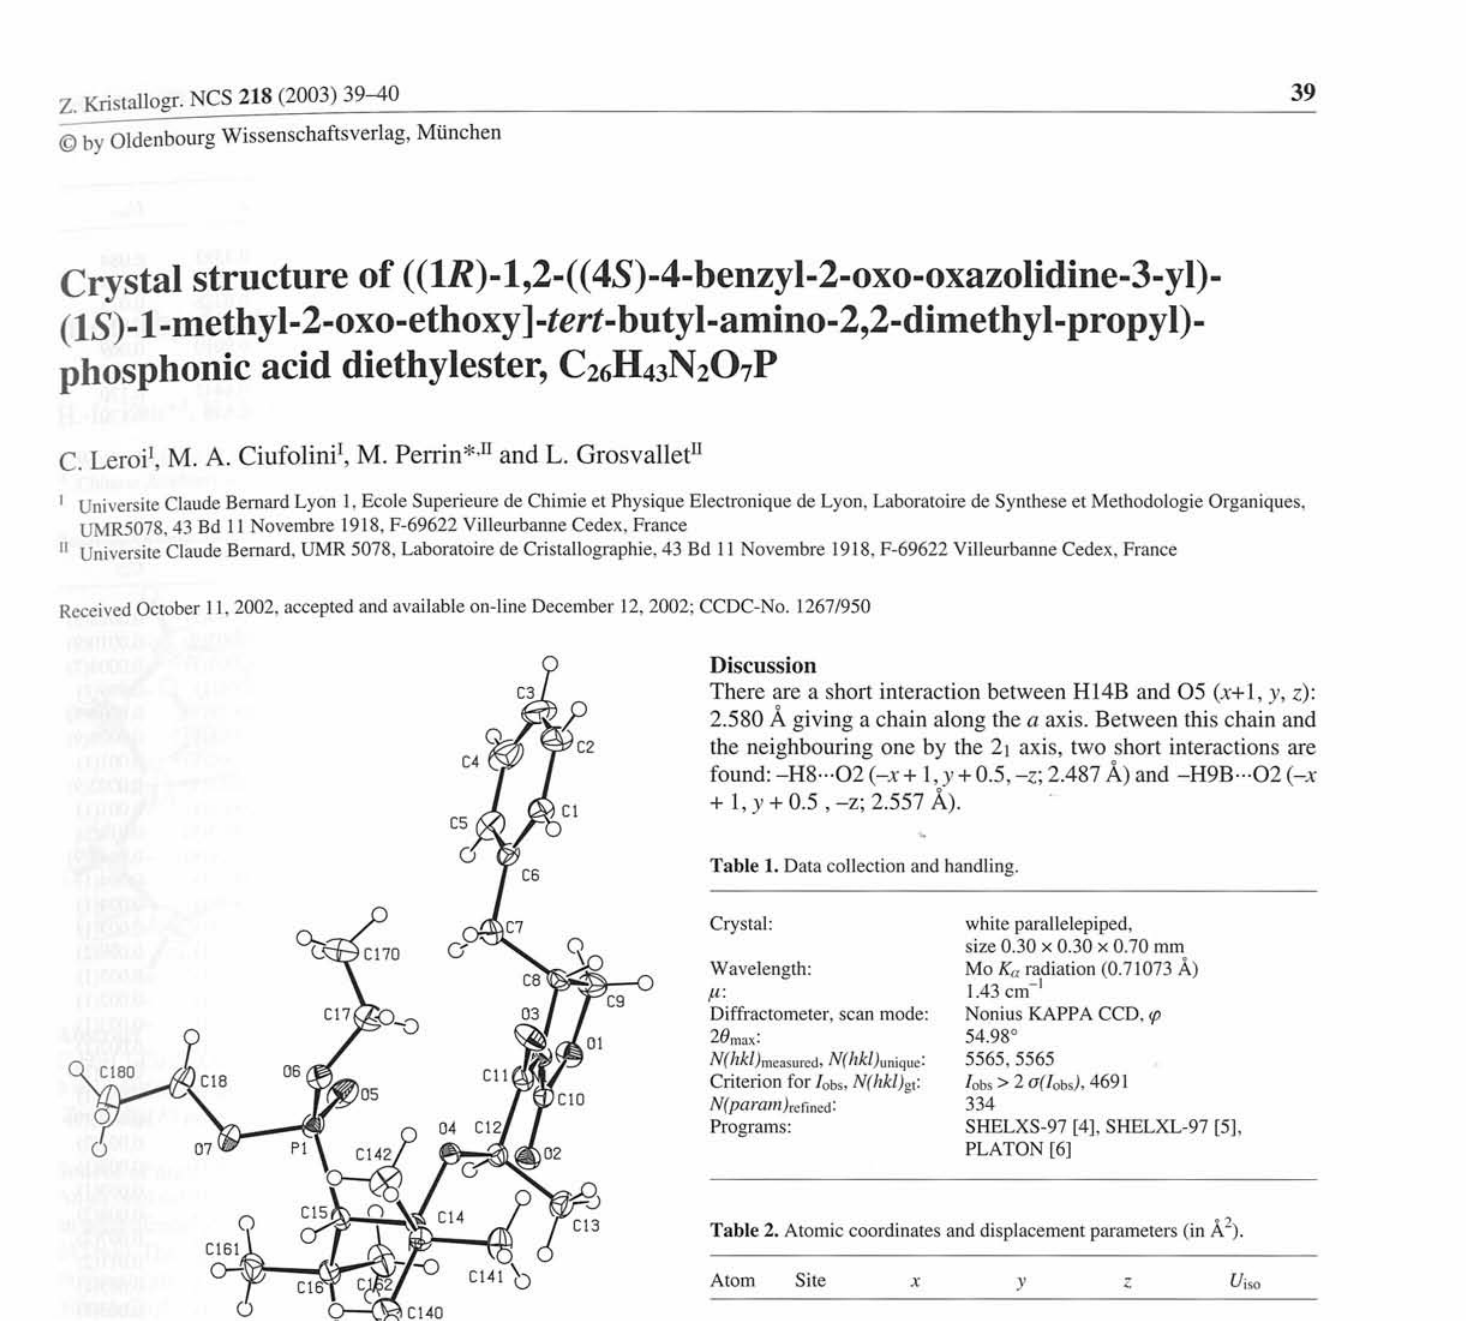
Table 2. Atomic coordinates and displacement parameters (in